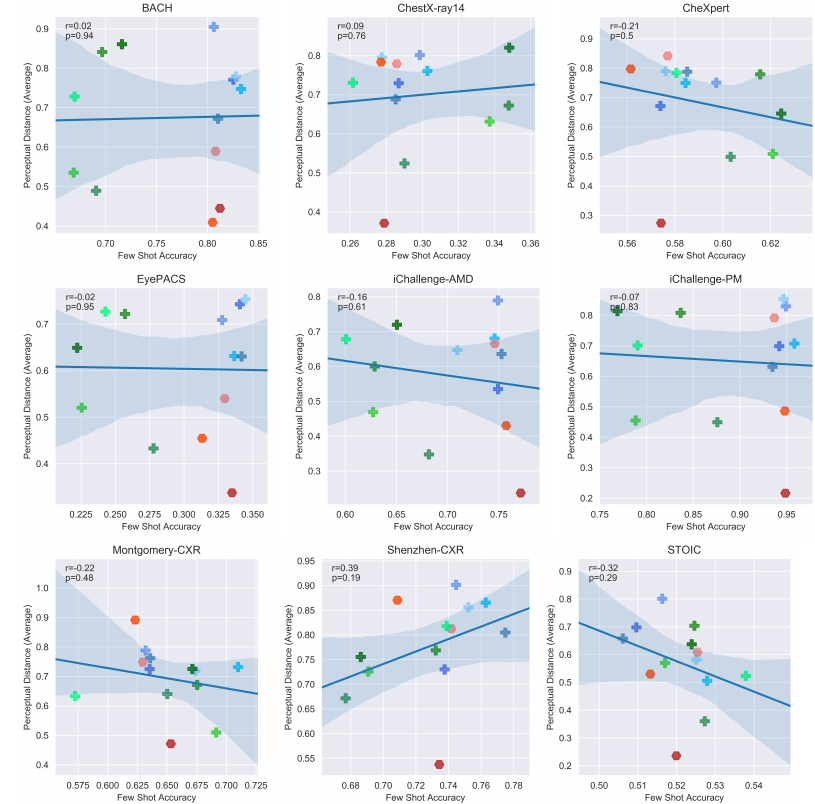
Figure A3. Perceptual distance values for the reconstructed images (averaged over the AlexNet, SqueezeNet, VGG architectures) plotted against transfer performance. Shown overlaid are the Pearson’s r correlation coefficients and associated p values.